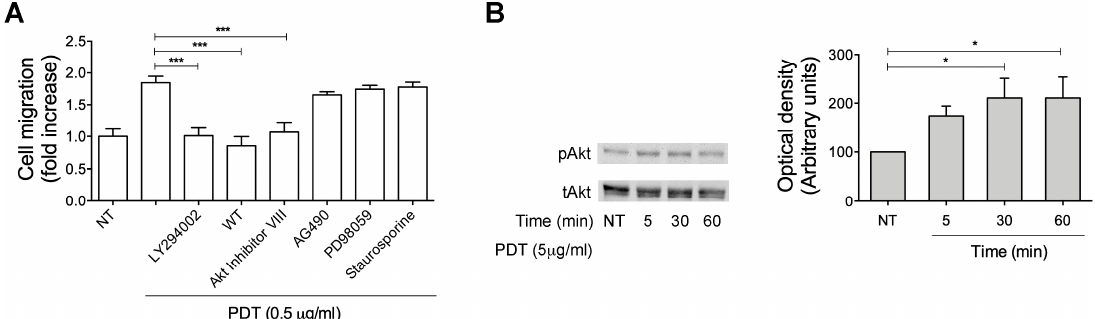
Figure 4. Signaling molecules involved in PDT-triggered monocyte migration. ( A ) Transwell migration assay of monocytes in response to the indicated treatments. Monocytes pretreated for 1 h at 37 ◦ C with the inhibitors LY294002 (25 µ M), wortmannin (100 nM), Akt inhibitor VIII (1 µ M), AG490 (100 µ M), PD98059 (10 µ M) and staurosporine (1 nM) were stimulated for 90 min at 37 ◦ C with PBS (NT) or PDT (0.5 µ g / mL). Bars represent the means ± SD of 3 independent experiments performed in triplicate. Statistical analysis was performed by one-way ANOVA and the Bonferroni’s post-test was used to compare data, *** p < 0.001. ( B ) Monocytes were stimulated with 5 µ g / mL of PDT at 37 ◦ C for the indicated times. Not treated cells (NT) were used as control (lane 1). Western blot analysis of monocyte lysates shows that PDT activates Akt, as shown by the respective phosphorylation state, verified by densitometric analysis and plotting of the phospho-Akt / total Akt (pAkt / tAkt). In the left panel blots from one representative experiment of three with similar results are shown. In the right panel, values reported for Akt phosphorylation are the mean ± SD of three independent experiments. Statistical analysis was performed by one-way ANOVA and the Bonferroni’s post-test was used to compare data, * p < 0.05.